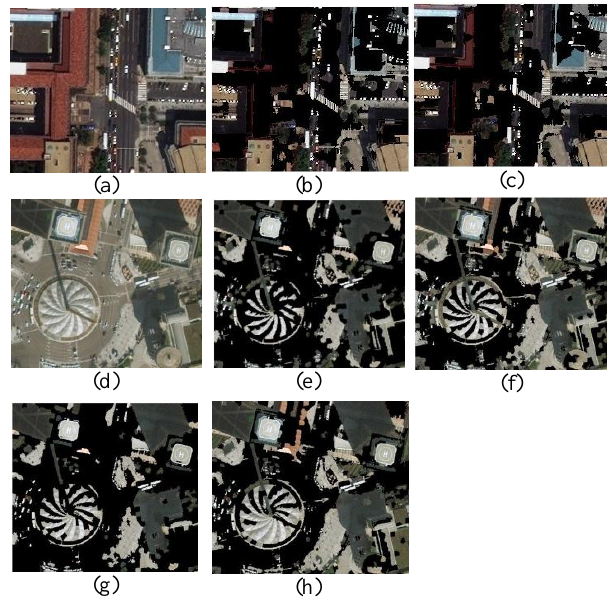
Figure 11. Image 1: (a) original image, (b)-(c) thresh >=mean/2 for Achanta 08, Achanta 09 respectively Image 2 : (d) original image (e) –(f) Achanta 08 at Thresh > = mean and >= mean/2 respectively (g)-(h) Achanta 09 atThresh >=mean and >=